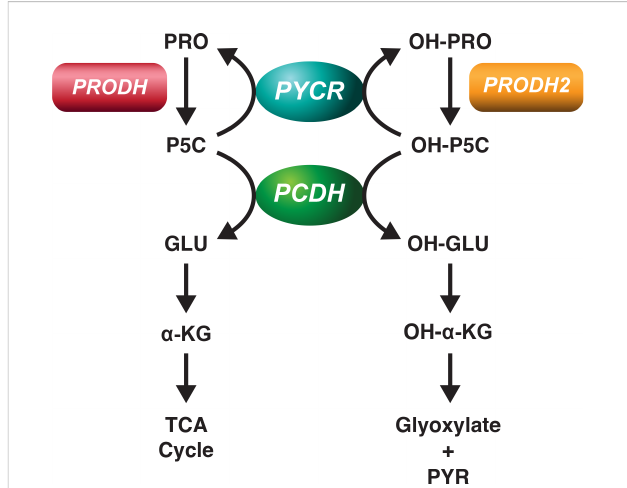
FIGURE 1 Metabolic Pathways for proline and hydroxyproline. Proline